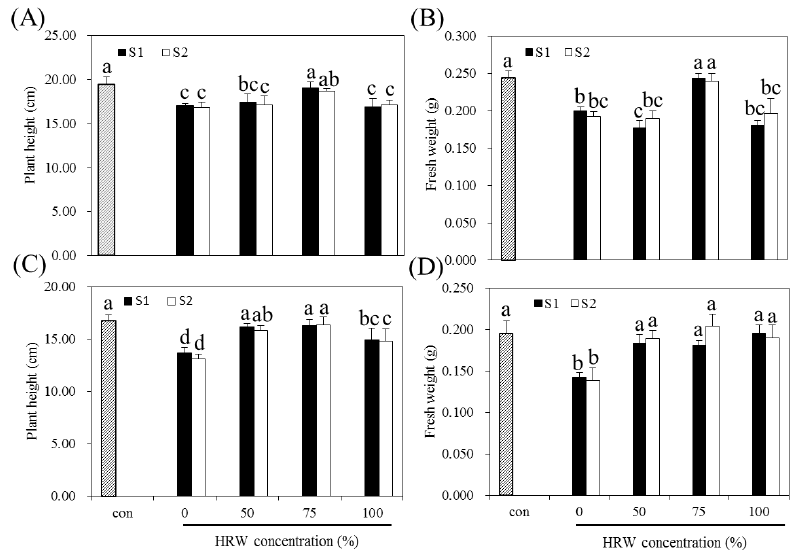
Figure 1. The effects of different concentrations of HRW (hydrogen-rich water) on rice plant height ( left ) and fresh weight ( right ) of indica ( A , B ) and japonica rice seedlings ( C , D ). S1 and S2 denote BS concentrations of 30 and 45 g a.i./hm 2 , respectively. Bars are the mean ± SE from three independent experiments. Different lowercase letters indicate significant differences at p < 0.05 according to Duncan’s multiple-range test.